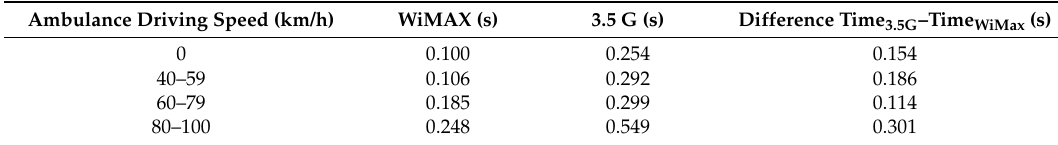
Table 2. Average end-to-end delay required for hospital to receive patient’s